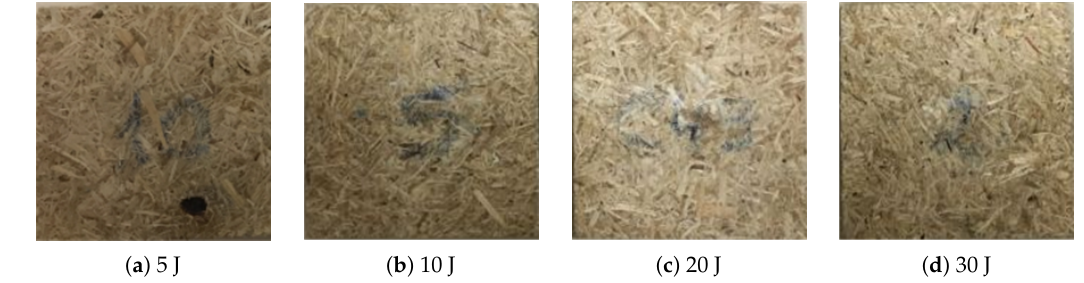
Figure 3. Photographs of the SCB laminates from the front side.